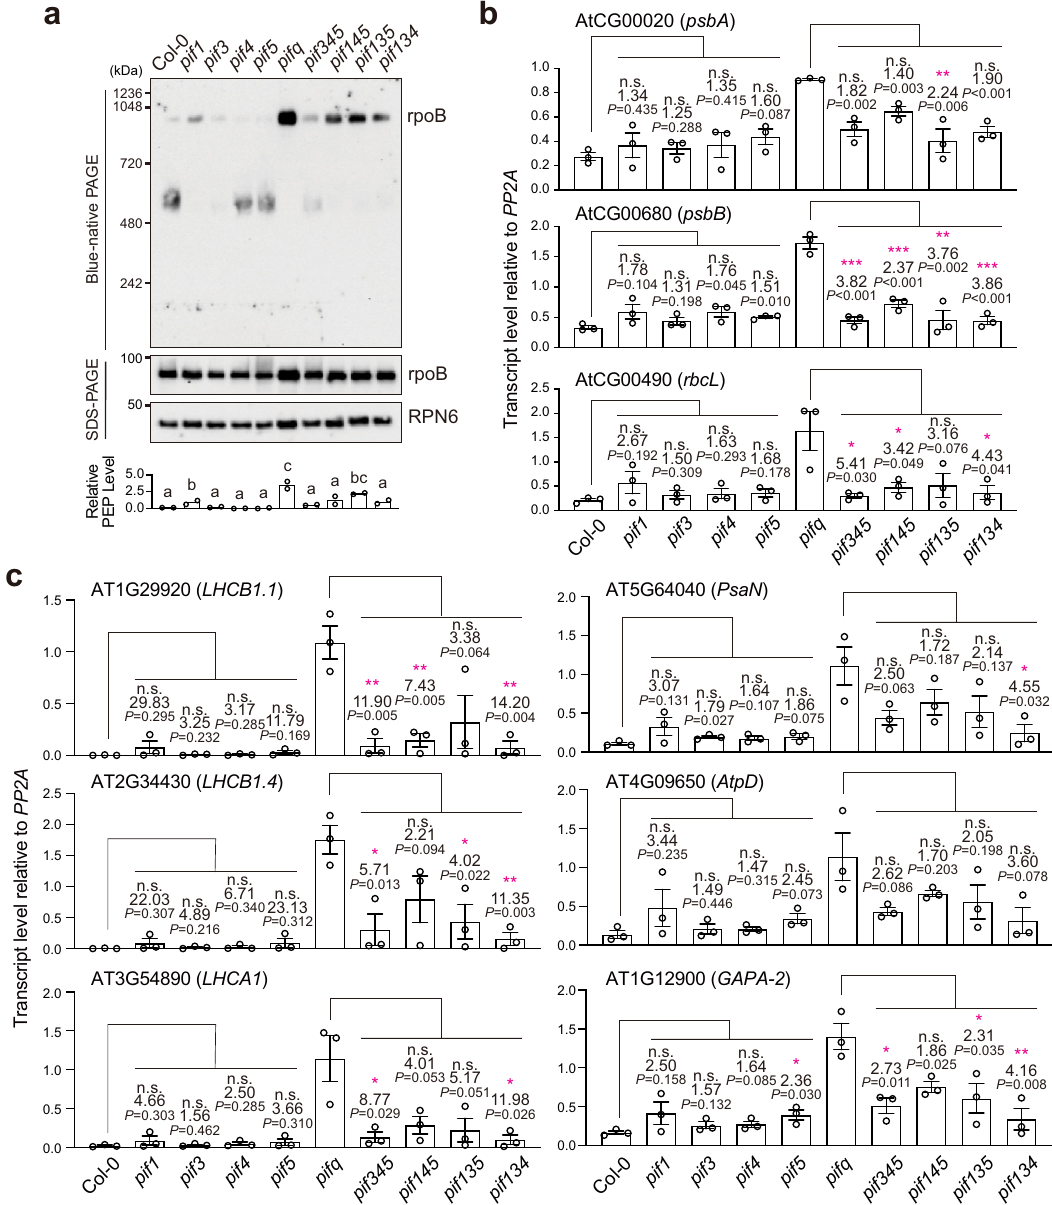
Fig. 5 | PEP activation is repressed redundantly by multiple PIFs. a Immunoblots showing the levels of the PEP complex and its core component rpoB in 4-d-old Col-0, pif1 , pif3 , pif4 , pif5 , pifq , pif345 , pif145 , pif135 , and pif134 seedlings grown in the dark. Total protein was isolated under either native or denaturing conditions and resolved via BN-PAGE or SDS-PAGE to assess the frac- tion of rpoB in the PEP complex or the amount of total rpoB by immunoblots, respectively. RPN6 was used as a loading control. The graph below the immuno- blotsshowstherelativePEPlevels,whichwereestimatedusingtherelativelevelof rpoBinthePEPcomplex(BN-PAGE)dividedbytherelativelevelofdenaturedrpoB (SDS-PAGE) in each sample. Different letters denote statistically signi fi cant differ- ences in relative PEP level either between the pif single mutants and Col-0 or between the pif triple mutants and pifq (ANOVA, Tukey ’ s HSD, P ≤ 0.05, n =2).